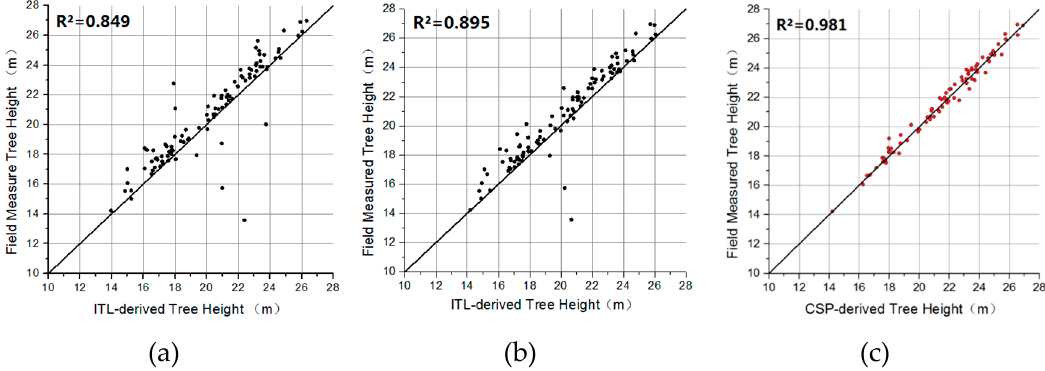
Figure 9. The comparison of ITL-derived, CSP-derived, and field-measured tree height ( a ) ITL: 0.2 m resolution; ( b ) ITL: 0.1 m resolution; and ( c ) CSP: 0.2 m resolution.